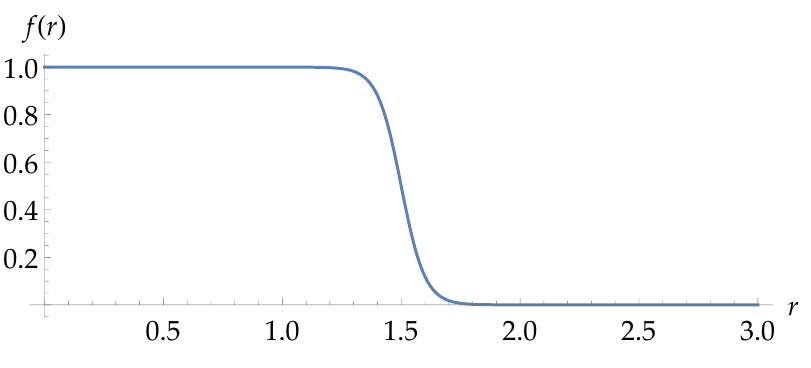
Figure 2: The function f ( r ) with R = 1.5 and (cid:34) =